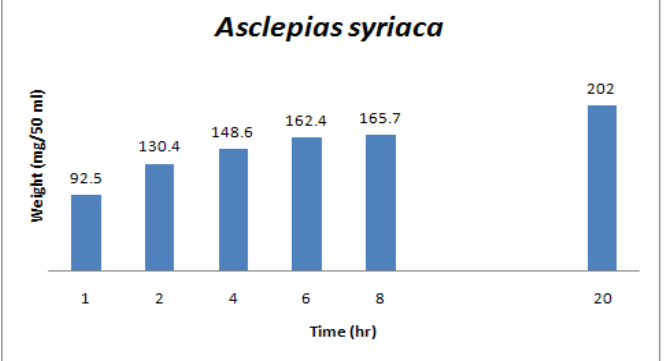
Figure 4. Increase in weight of organic solvent extractables as a function of contact